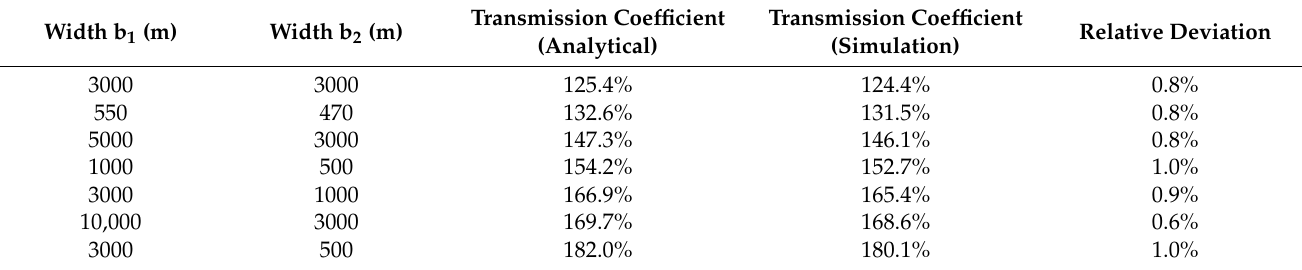
Table 5. Comparison of calculated and simulated transmission coefficients for a depth ratio 17/6 and different width ratios. Width b 1